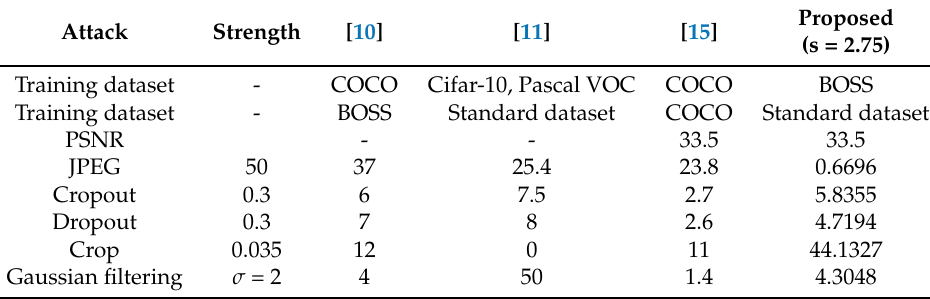
Table 7. Comparison of the proposed method with recent